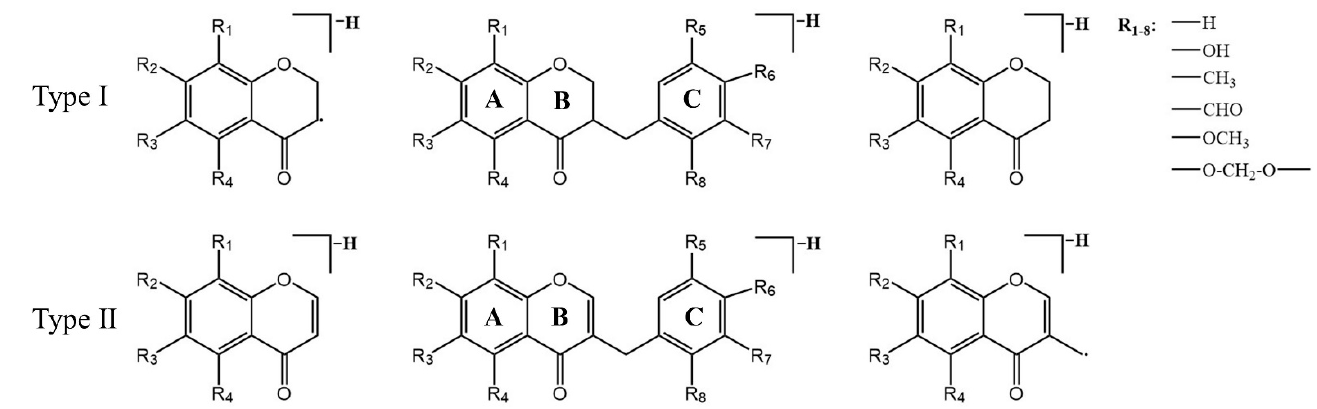
Figure 4. Proposed fragment ions from the predominant fragmentation of homoisoflavonoids.